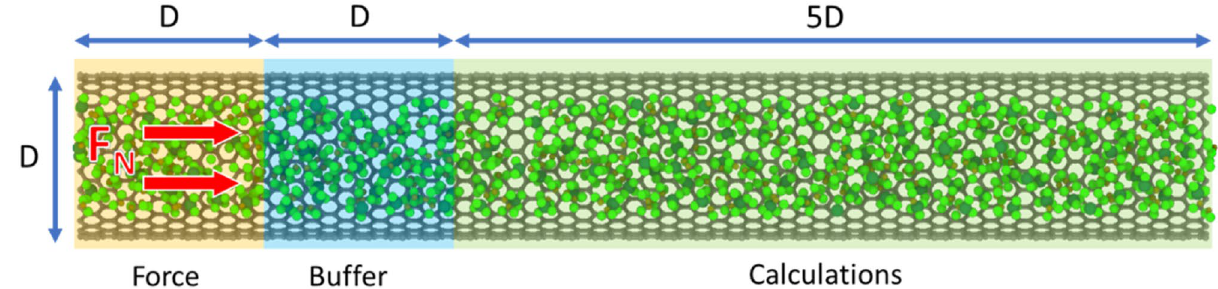
Figure 8. CNT filled with fluid and force F N applied on all the carbon atoms to simulate the flow. The blue dashed line represents the periodic boundary. Created using OVITO